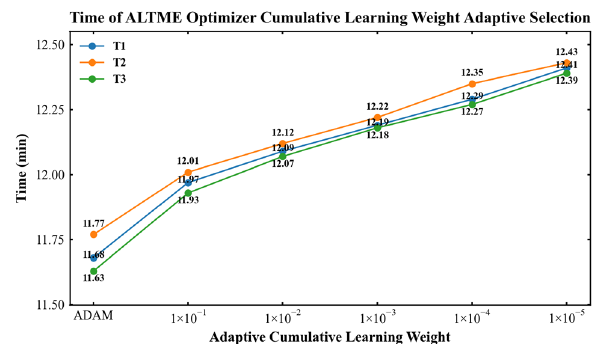
Figure 17. Time of ALTME optimizer cumulative learning weight adaptive selection.